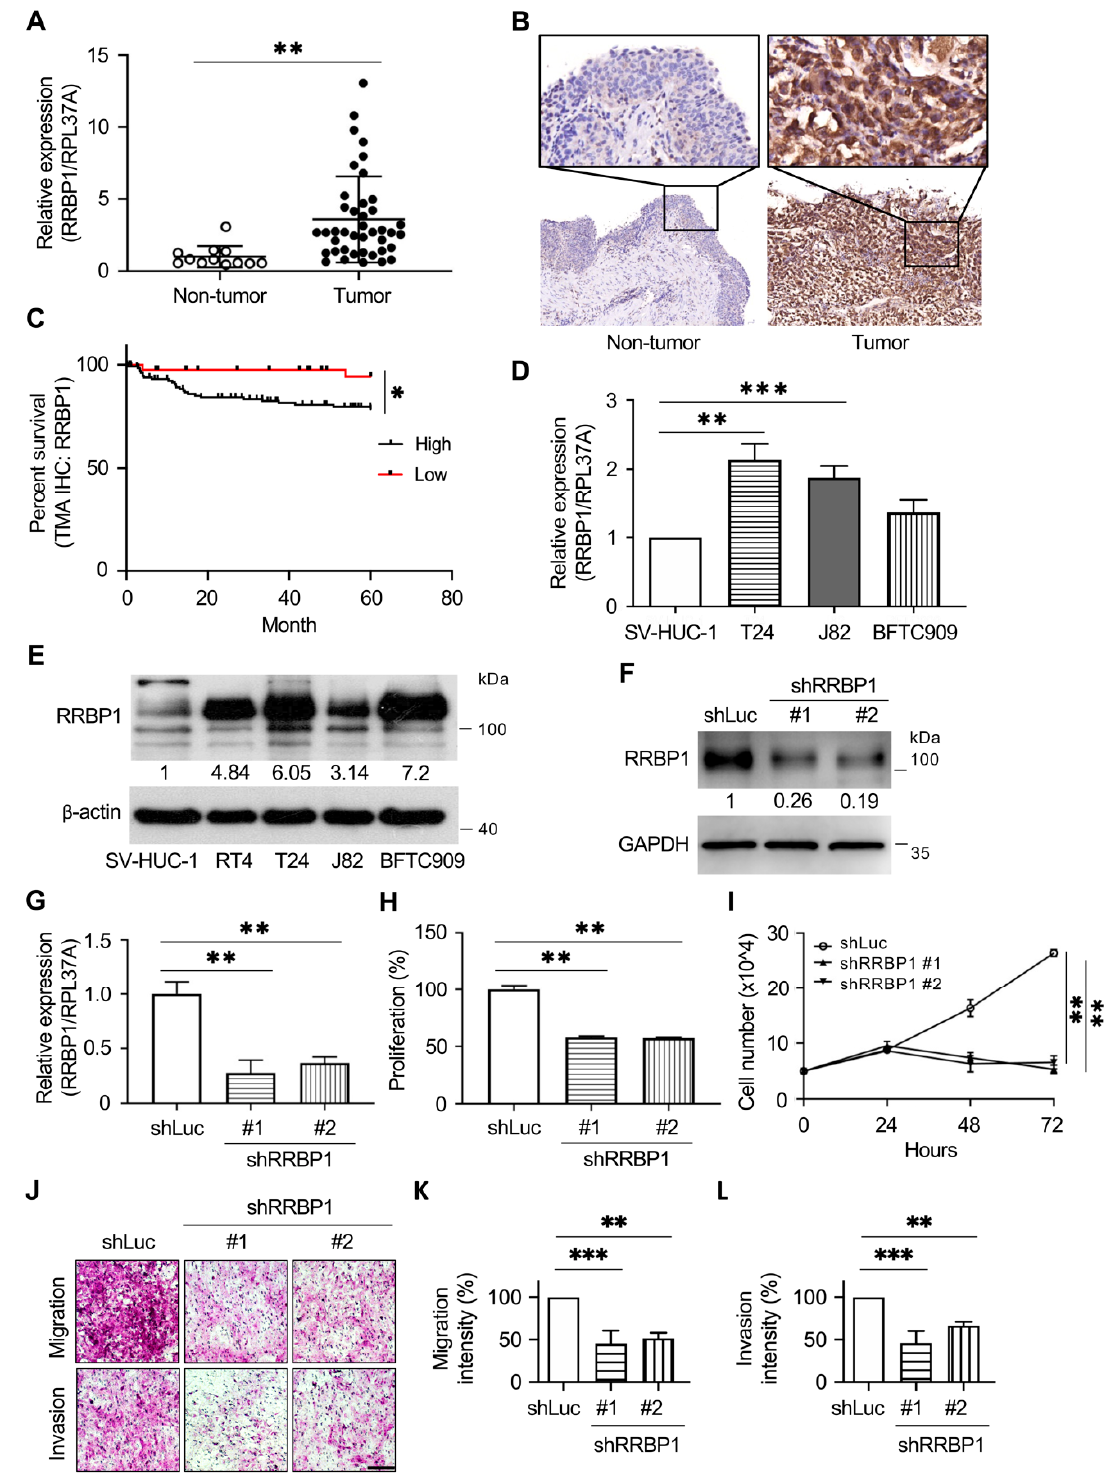
Figure 4. High expression of RRBP1 in tumors from patients with UTUC. ( A ) Levels of RRBP1 mRNA are higher than nontumor in UTUC. The mRNA expression of RRBP1 was analyzed based on the unlinked database from National Health Institute. (** p < 0.01.) Student t -test with two-tailed p -value. ( B ) High expression of RRBP1 in tissues from UTUC tumors. Tissues of nontumor and tumor were fixed and embedded in paraffin. Immunohistochemistry staining of tissue sections was performed with RRBP1 antibody. ( C ) Analysis of survival within five years according to the immunohistochemistry staining in tumor tissue microarray ( n = 197). (* p < 0.05.) Log-rank test. ( D ) Relative expression of RRBP1 in cell lines. mRNA of SV-HUV1, J82, T24, and BFTC909 cells were collected for quantitative PCR assay targeting RRBP1 (** p < 0.01; *** p < 0.001.). ( E ) Protein expression of RRBP1 in cell lines. Cell lysates were harvested and protein expression was detected